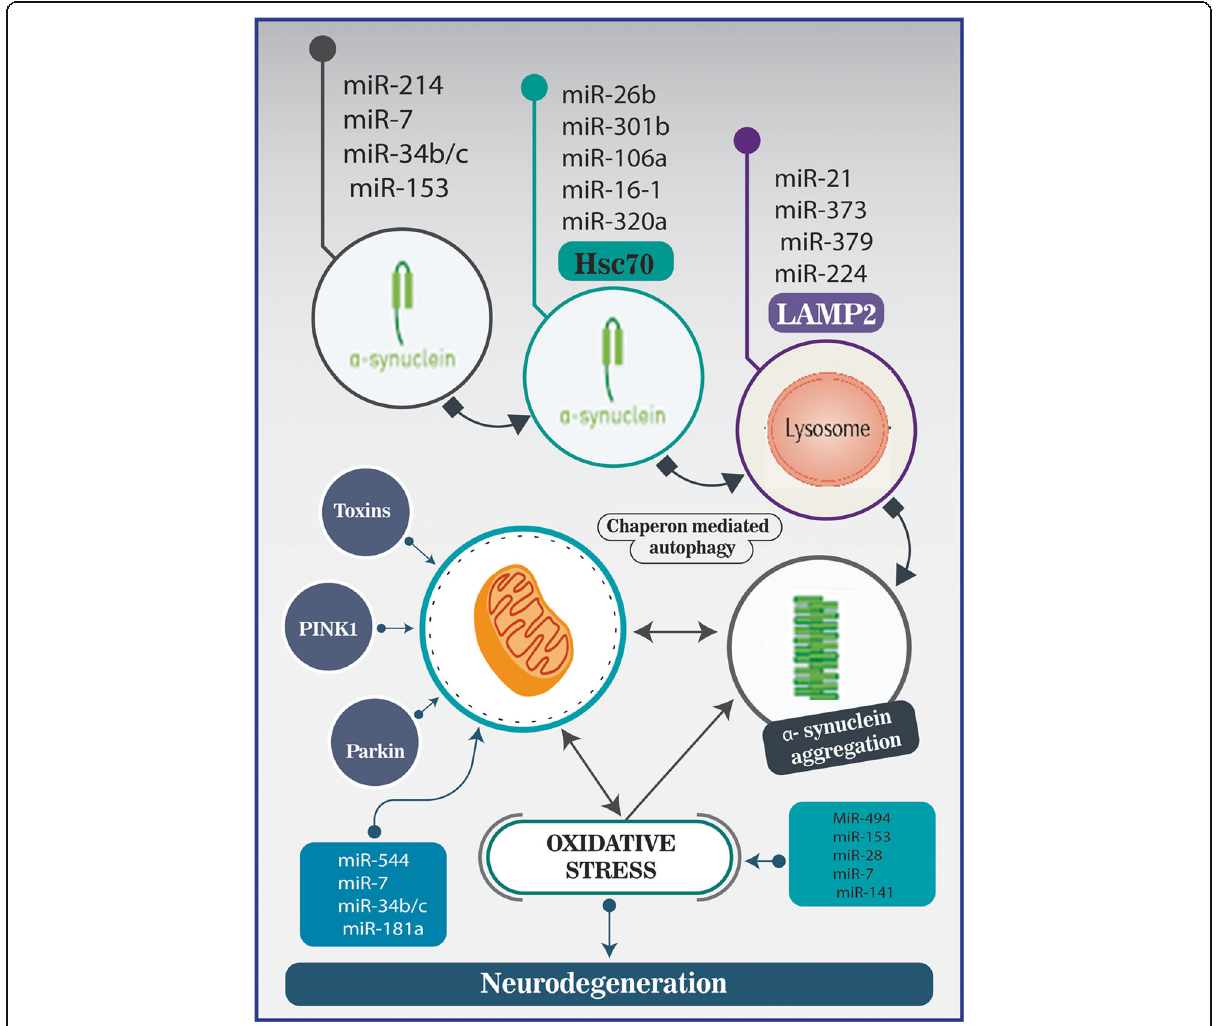
Fig. 2 Micro RNAs dysregulation in Parkinson disease. Multiple microRNAs were reported to control α -synuclein aggregation either by direct regulation or by chaperon-mediated autophagy. Others control mitochondrial function or oxidative stress. LAMP2A: Lysosomal-associated membrane protein 2A, Hsp70: heat shock protein